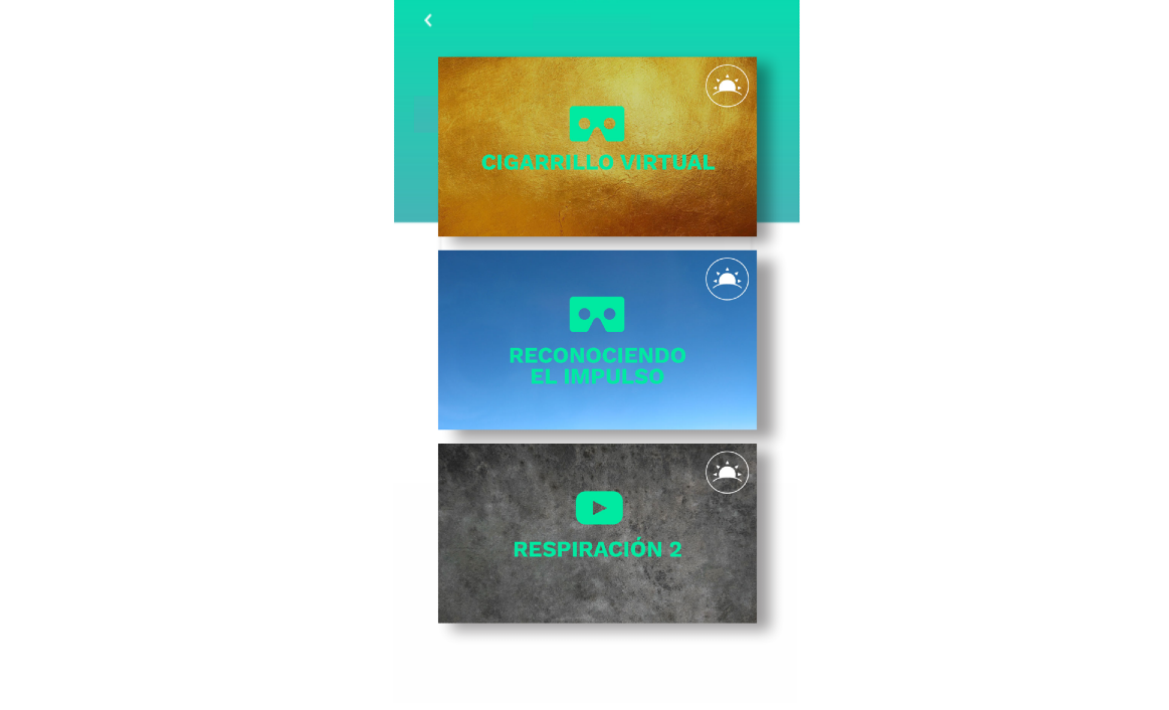
Figure 4. App screenshot of the nightly